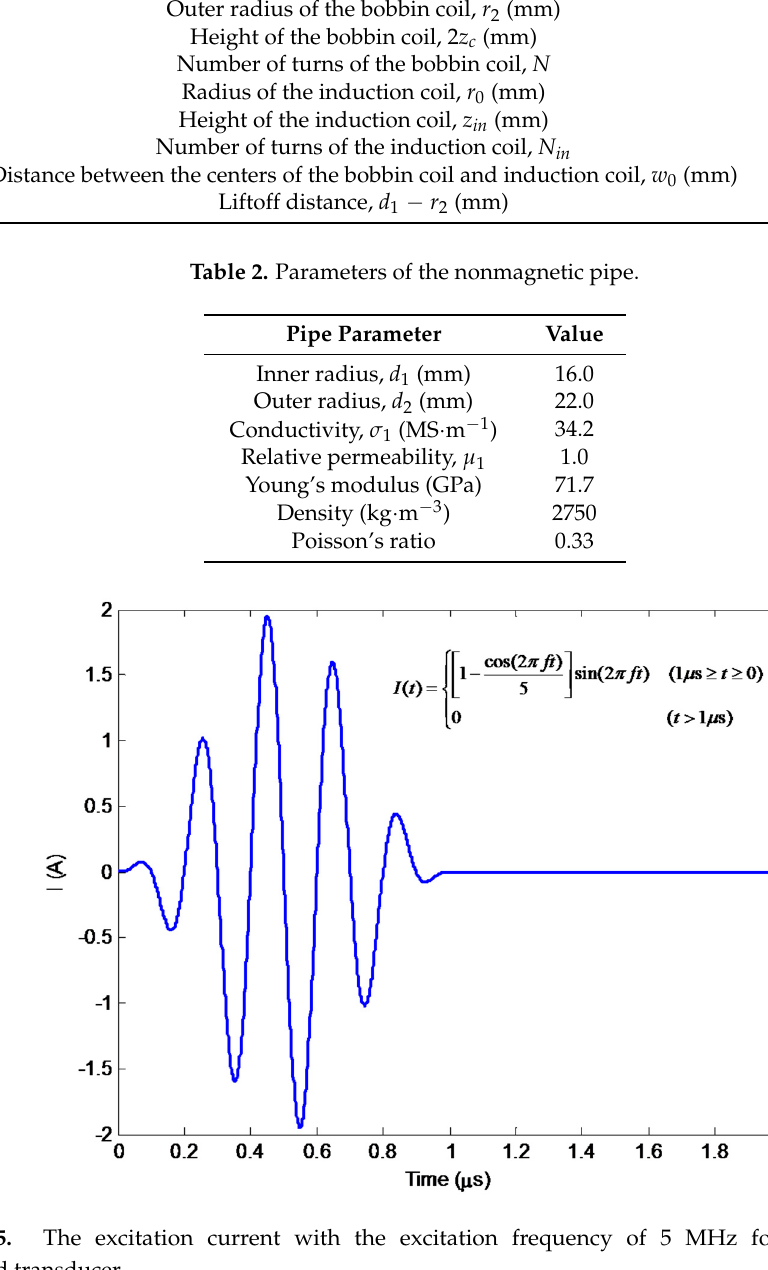
Table 1. Parameters of the proposed transducer.